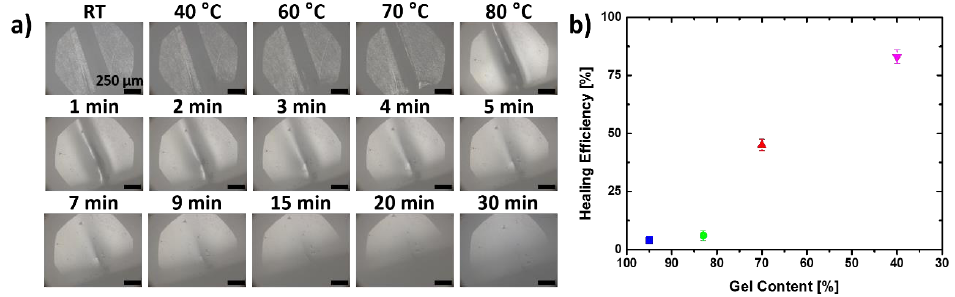
Figure 6. ( a ) Picture series heating a damaged plane film of cPCL 40 -L 60 network at different temperatures and after different time steps leading to closure of the cut due to melting of linear PCL. (spherical shape of image results by the microscopes objective causing this effect); ( b ) Healing efficiency of cPCL 95 -L 05 (blue), cPCL 83 -L 17 (green), cPCL 70 -L 30 (red) and cPCL 40 -L 60 (magenta) vs. gel content estimated by comparison of the mechanical tensile properties of the pristine, damaged and healed sample at ambient temperature.